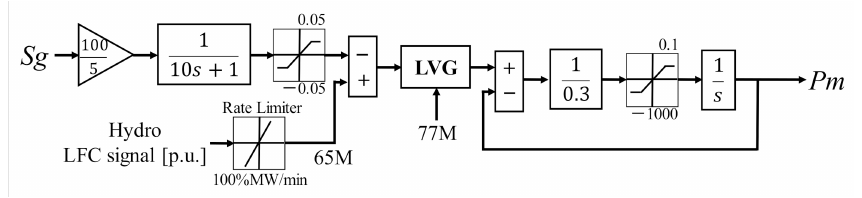
Figure 2. Hydro governor.